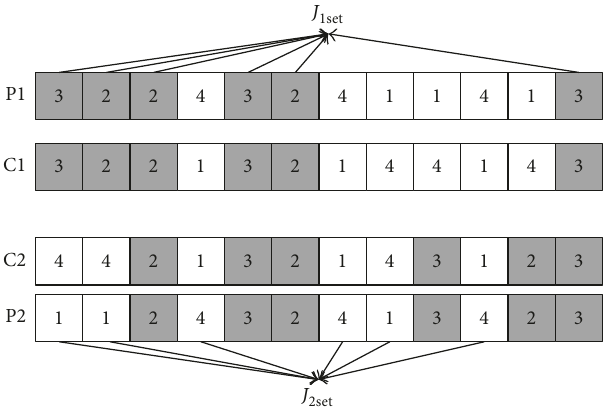
Figure 5: Crossover operation for operation